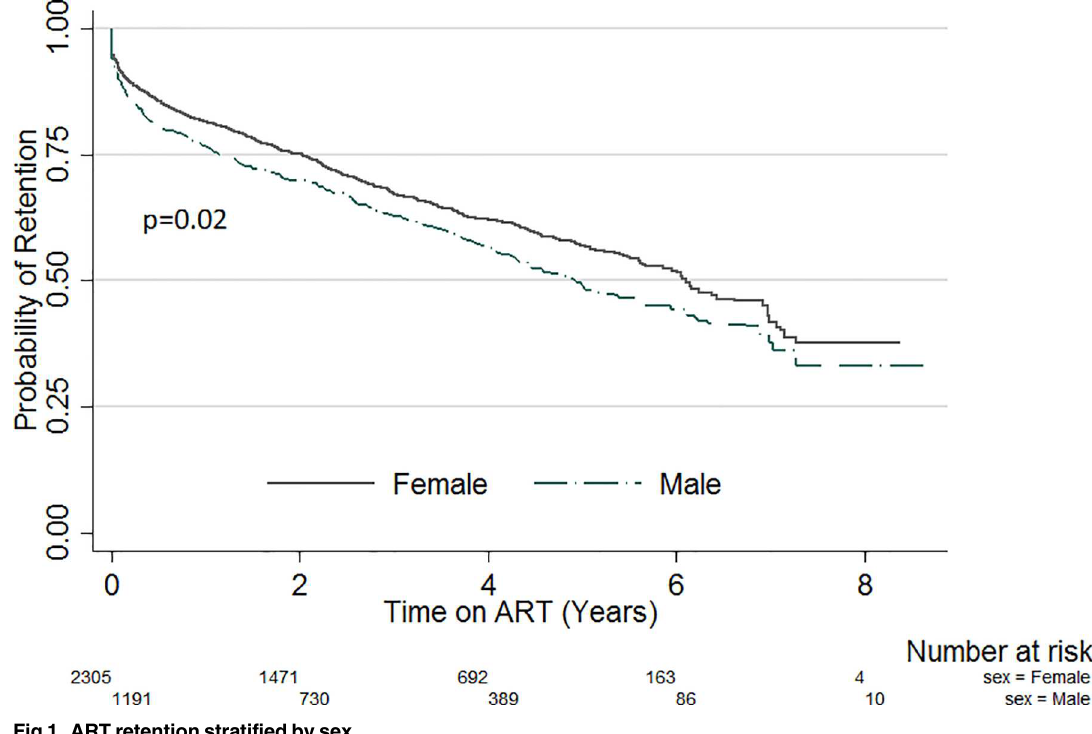
Fig 1. ART retention stratified by sex.